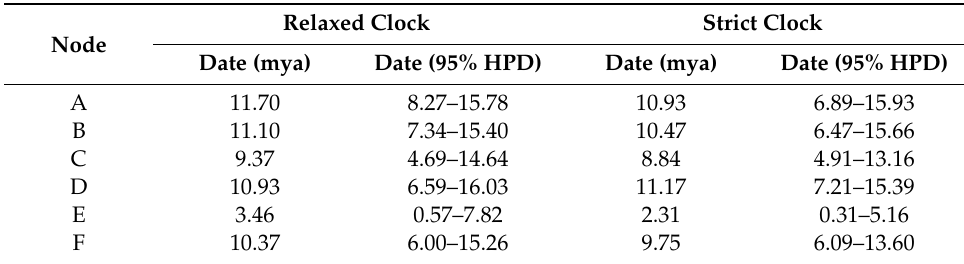
Table 4. Divergence times calculated by using relaxed and strict clocks in the expanded chronogram in Figure